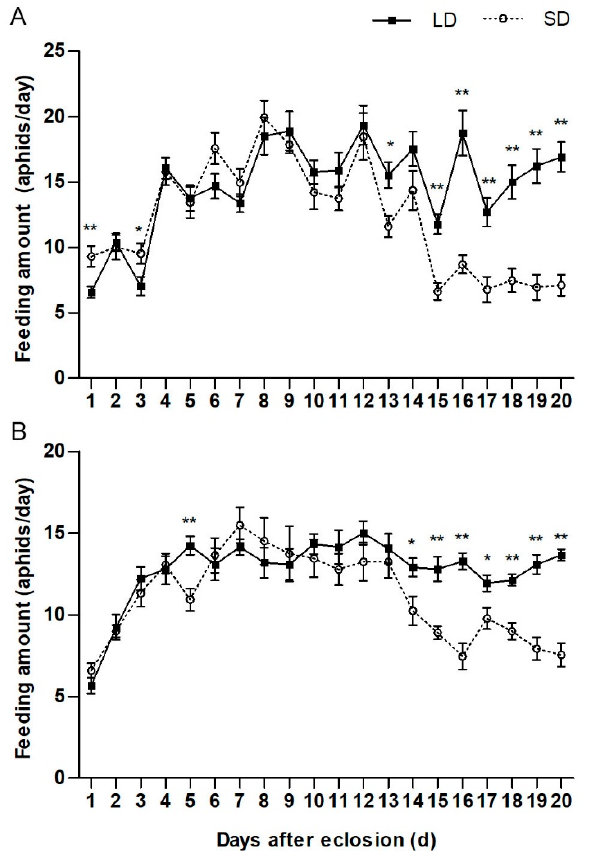
Figure 3. Dynamic changes in feeding amount in pre-diapause and pre-reproductive adult H. axyridis . Dynamic change in daily feeding amount of female ( A ) and male ( B ) H. axyridis . All values are means ± standard error estimated from 15 independent biological replicates. LD = pre-reproductive beetles reared under a long-day condition and SD = pre-diapause beetles reared under a short-day condition. Asterisks indicate significant differences identified by an independent samples t -test (* p < 0.05, ** p < 0.01).